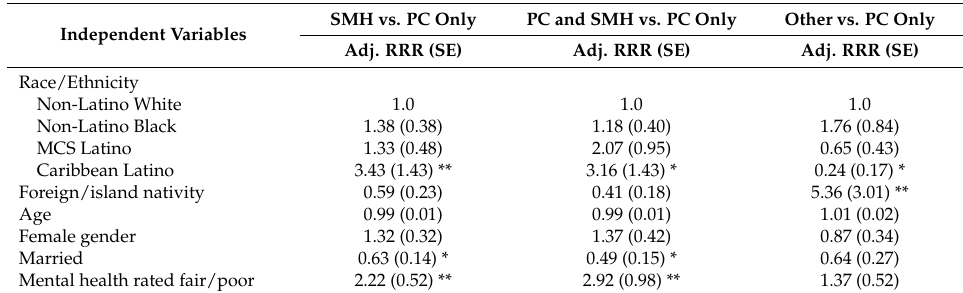
Table 4. Racial/Ethnic Differences in Type of Mental Health Providers and Number of Visits, Conditional on any Mental Health Visit. SMH vs. PC Only PC and SMH vs. PC Only Other vs. PC Only Independent Variables